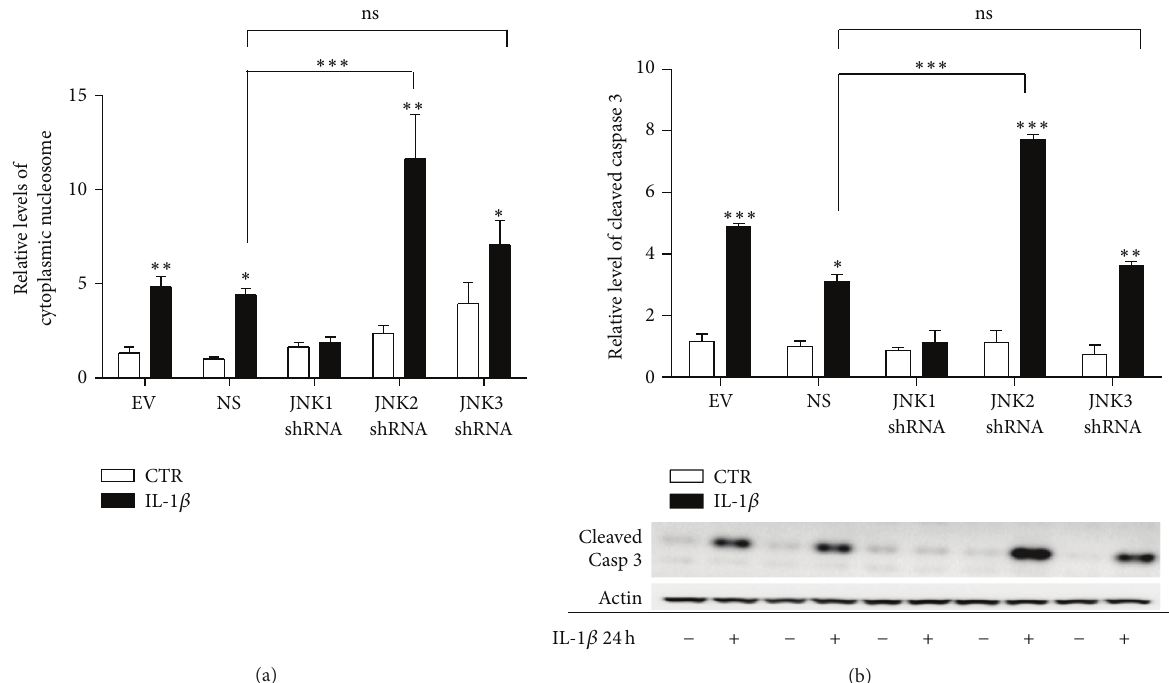
Figure 4: JNK1 knockdown attenuates IL-1 𝛽 -induced caspase 3 activation and apoptosis in INS-1 cells. Stable INS-1 cell lines expressing shRNA for JNK1, JNK2, JNK3, nonsense shRNA, or empty vector controls were exposed to 150 pg/mL IL-1 𝛽 (closed bars) or vehicle (open bars) for 24 h. (a) Apoptosis was measured as the relative levels of cytoplasmic nucleosomes in INS-1 stable cell lines lysates using the Roche Cell Death detection Elisa kit. Data are shown as means ± SEM of 𝑛 = 5 independent experiments. (b) Cleaved caspase 3 was assessed with immunoblotting and normalized to actin. Data are shown as means ± SEM of 𝑛 = 4 independent experiments; ∗ 𝑃 < 0.05 , ∗∗ 𝑃 < 0.01 , and ∗∗∗ 𝑃 < 0.001 , comparing caspase 3 activity in the presence with the activity in the absence of IL-1 𝛽 , unless otherwise indicated. Representative gels are